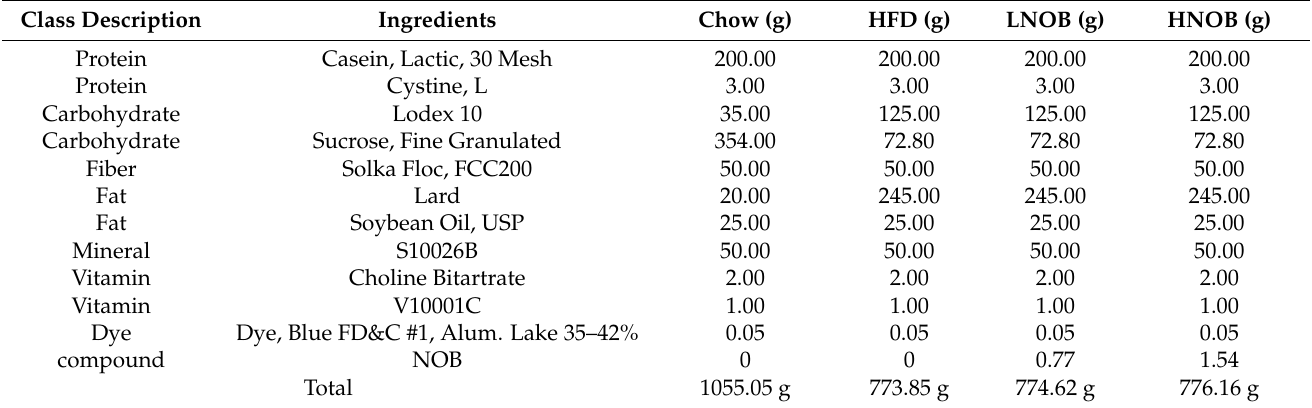
Table 1. Composition of animal